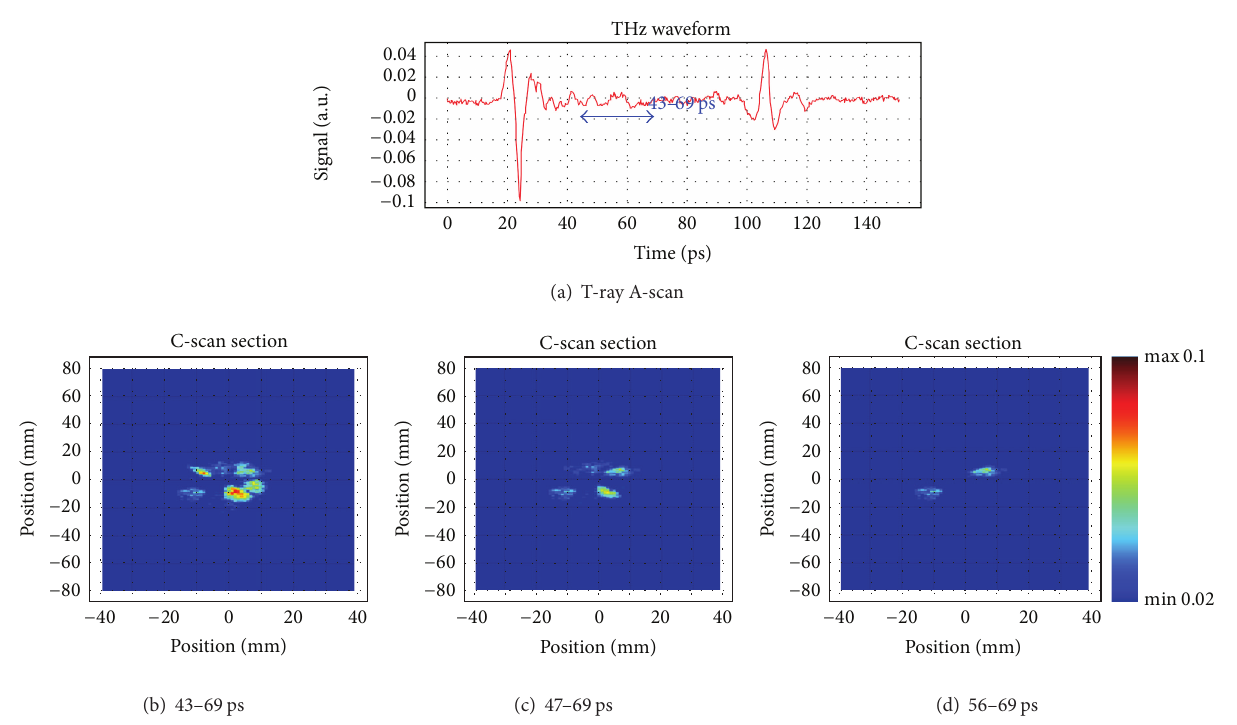
Figure 8: Time-domain TDS waveform of glass composite laminate (a) and impact delamination images using different time gates (from